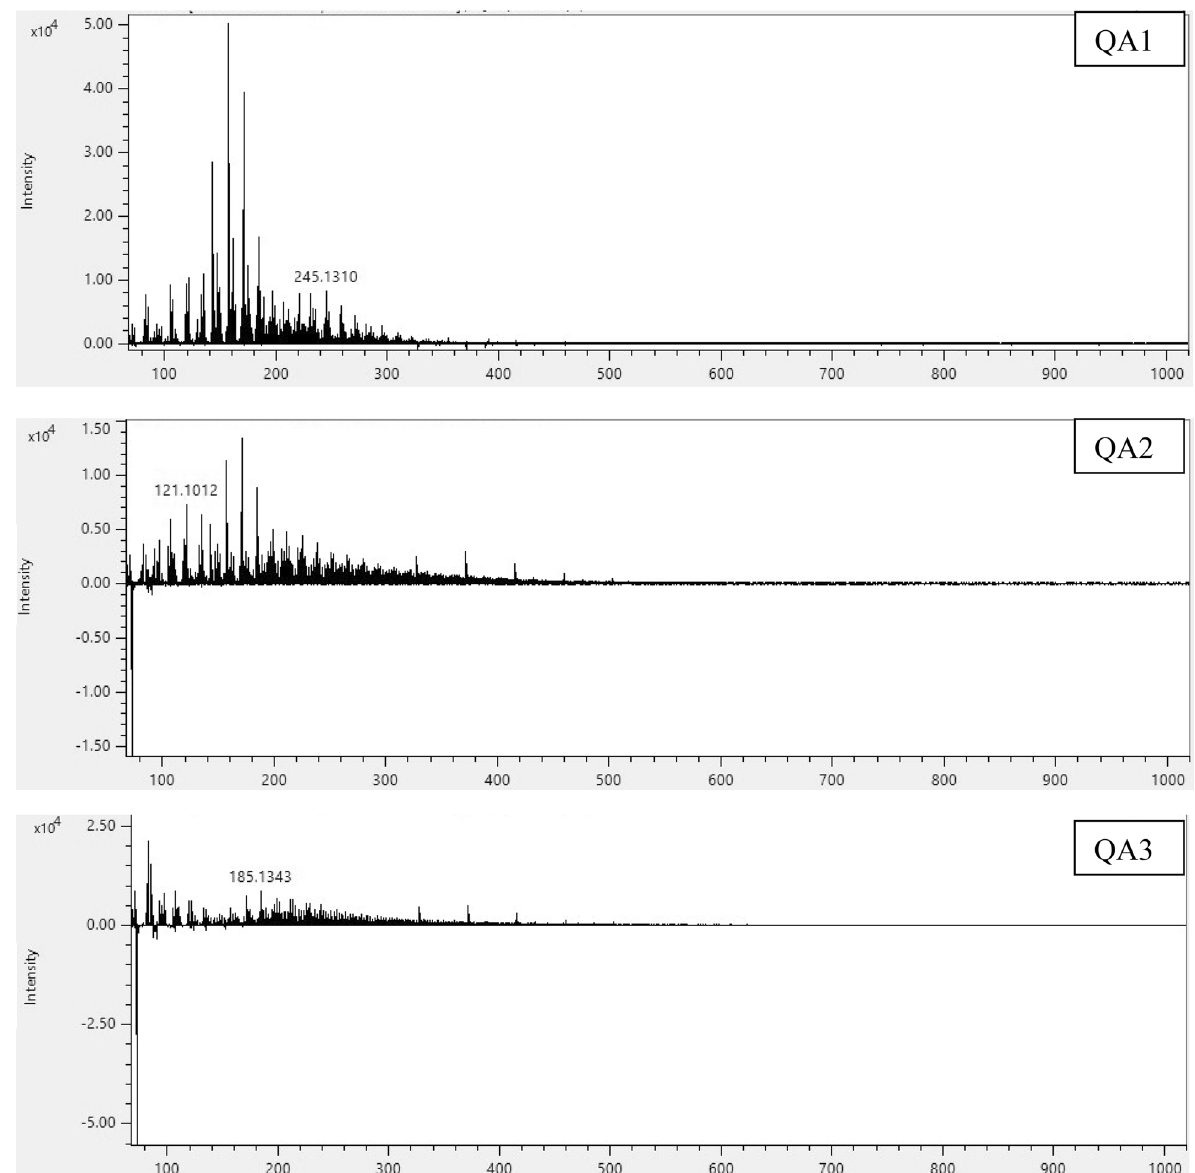
Fig. 3 Spectra of QA1, QA2 and